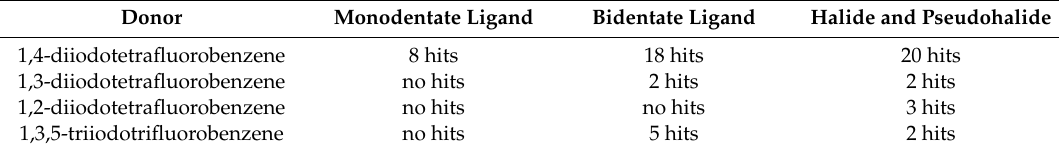
Table 1. The number of unique datasets in the Cambridge Structural Database (version 5.41, March 2020) corresponding to cocrystals of coordination compounds with the selected series of halogen bond donors